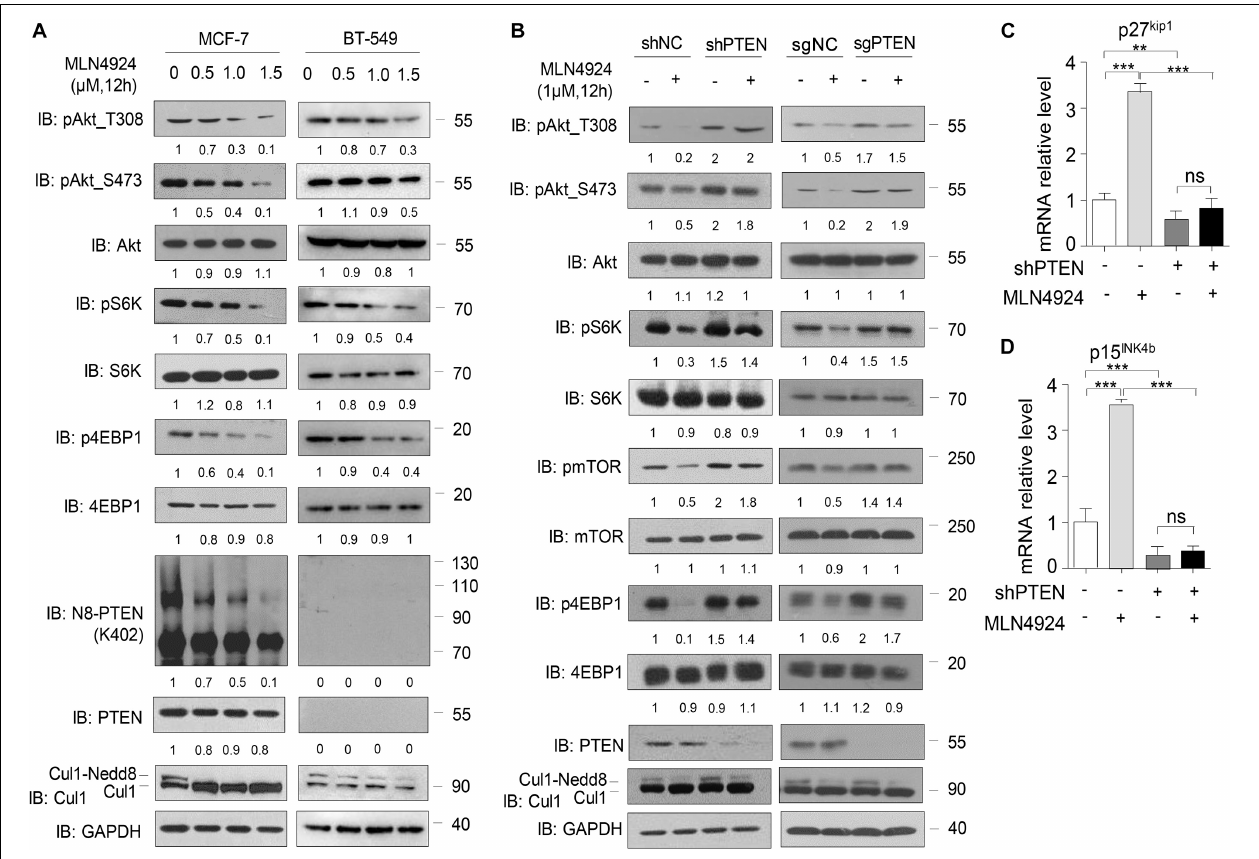
FIGURE 2 | PTEN is indispensable for MLN4924 to inhibit PI3K/Akt signaling pathway activity. (A) Immunoblot of WCL from MCF-7 cells and BT-549 ( PTEN -null) cells with MLN4924 treatment (1 µ M) for 12 h. (B) Immunoblot of WCL from shNC/Control or shPTEN/sgPTEN MCF-7 cells. The cells were treated with 1 µ M MLN4924 for 12 h. (C,D) Quantitative mRNA level analysis of p27 kip1 and p15 INK4b in shNC and shPTEN MCF-7 cells. MLN4924 was used at indicated dose (1 µ M; 12 h). The quantifications of indicated protein contents were analyzed. * P < 0.05, ** P < 0.01, *** P <